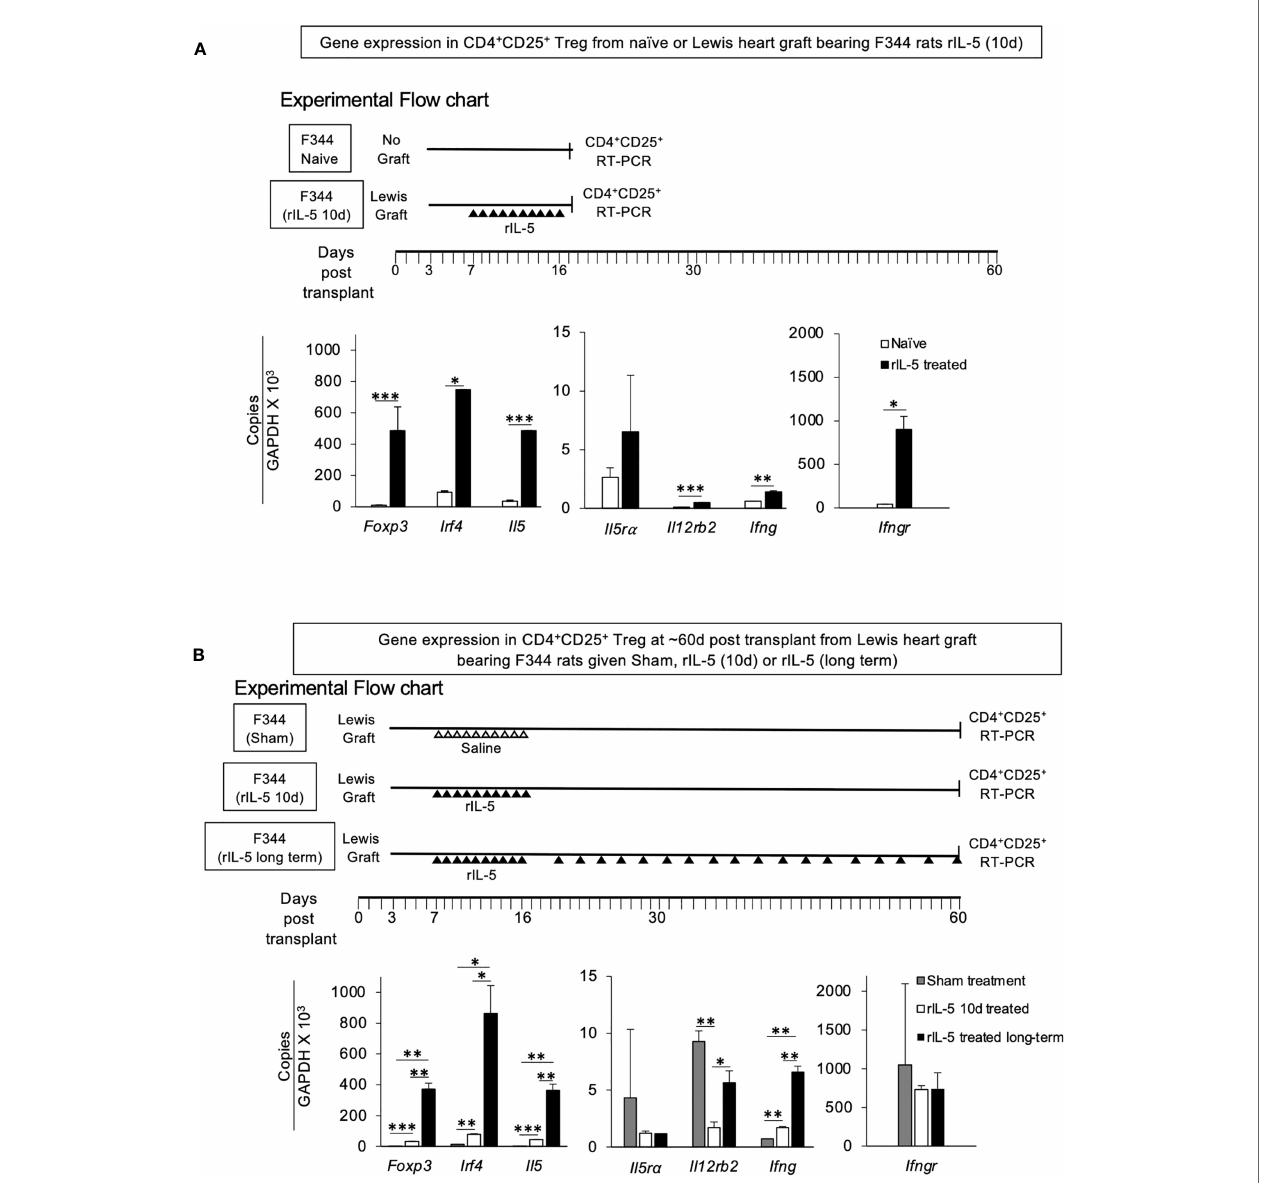
FIGURE 7 | RT-PCR assays of mRNA for transcription factors, cytokines and cytokine receptors in CD4 + CD25 + T cells from F344 rats. (A) Comparison of RT-PCR of mRNA of CD4 + CD25 + T cells from naïve F344 to those from F344 rats bearing Lewis heart graft treated with rIL-5 for 10 days. CD4 + CD25 + cells were enriched from lymph node and spleens of F344 rats as described in methods and subjected to mRNA extraction. mRNA prepared at 16 days post transplantation from F344 rats bearing Lewis heart grafts and treated with rIL-5 for 10 days was compared to that from naive F344 rats that had no transplant and no treatment (Experimental Flow Chart). mRNA was subjected to cDNA extraction followed by RT-PCR of transcription factors, cytokines and cytokine receptors associated with activation of naive CD4 + CD25 + T cells by alloantigen and either IL-2 ( Ifngr, Il12rb2) or IL-4 ( Irf4 and Il5ra ). CD4 + CD25 + T cells from rIL-5 treated graft bearing hosts had more Foxp3 consistent with activation of Treg, and more Il5 , and Irf4 , consistent with induction of Th2-like Treg. There was also induction of Ifngr, Ifng and Il12rb2 consistent with induction of Treg by Type-1 cytokines (28, 29). *p < 0.05, **p < 0.01, ***p < 0.001. (B) Comparison of RT-PCR of mRNA from CD4 + CD25 + cells from F344 hosts with Lewis heart grafts at >56 days. CD4 + CD25 + T cells from spleen and lymph nodes of F344 rats treated with rIL-5 for short term (10 days) or long-term were compared to those from sham treated hosts (Experimental Flow Chart). CD4 + CD25 + T cells in long-term rIL-5 treated animals were not increased and was ~6.4% (data